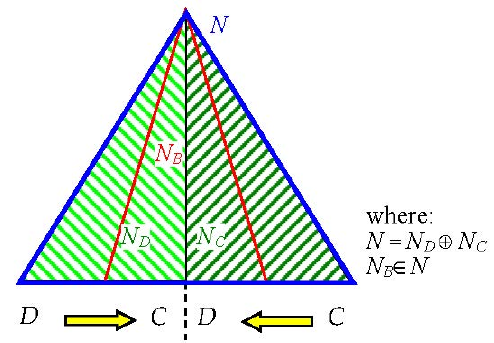
Figure 3. Graphical interpretation of the division of a set of harmonics.